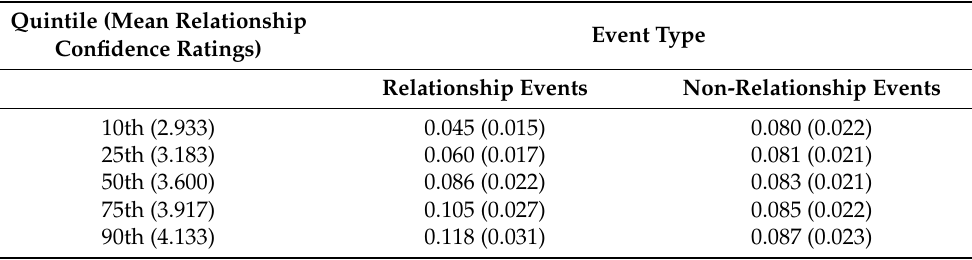
Table 7. Conditional Indirect Effects of Fading Affect Bias (FAB) for Relationship and Non- Relationship Events across Quintiles of Self-Reported Relationship Confidence Ratings through Event Rehearsal Frequency